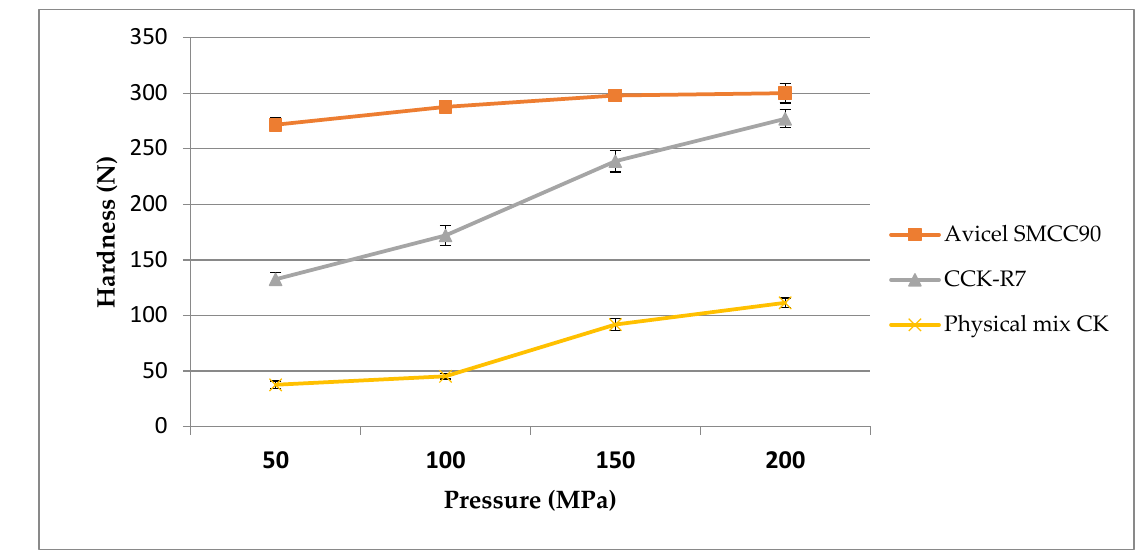
Figure 7. The hardness pressure profile of Avicel SMCC90 ® , CCK-R7, and the physical mixture of chitosan and kaolin.